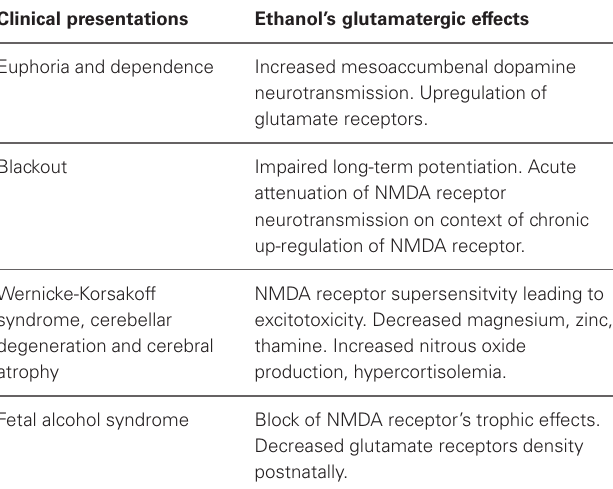
Table 2 | Glutamatergic hypothesis of alcoholic brain injury (Adapted from Tsai and Coyle,